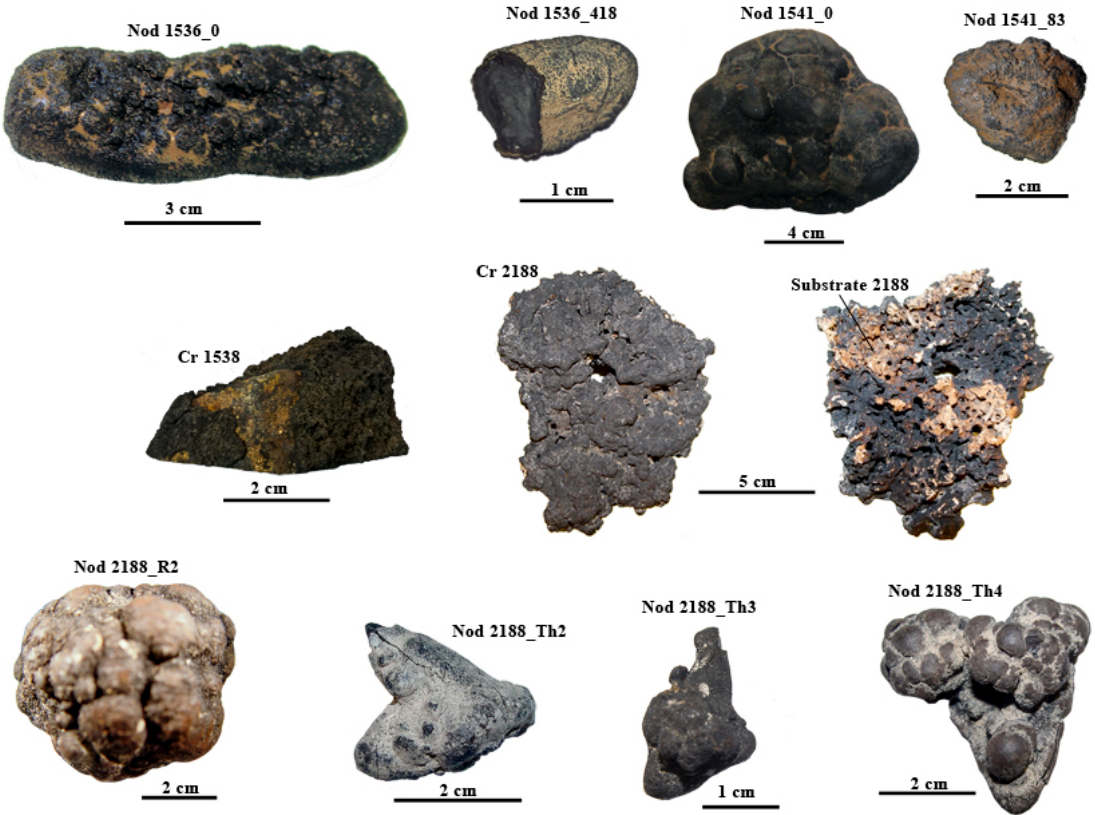
Figure 2. Photographs of the crust and nodules from the Brazil and Cape Basins.